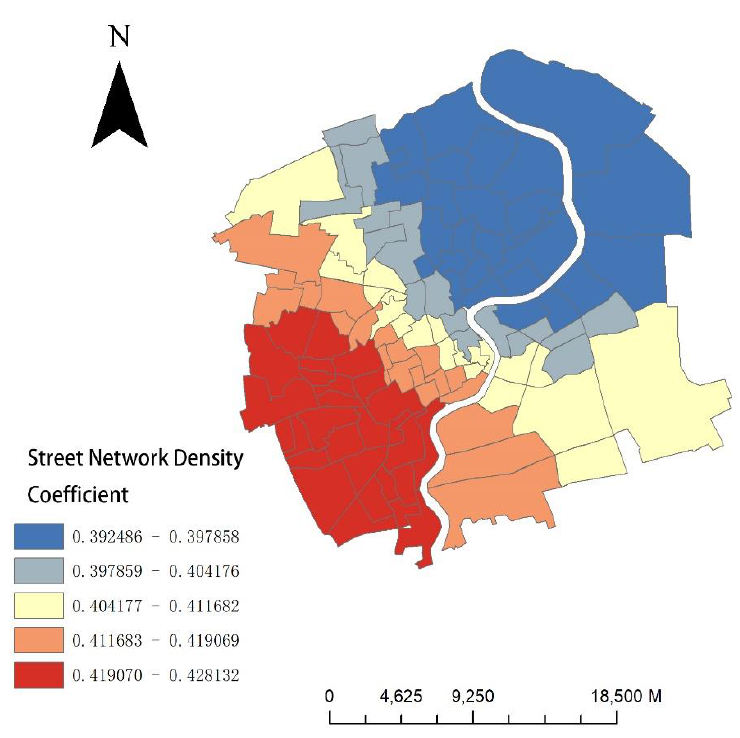
Figure 14. Street-network-density coefficients at each county or